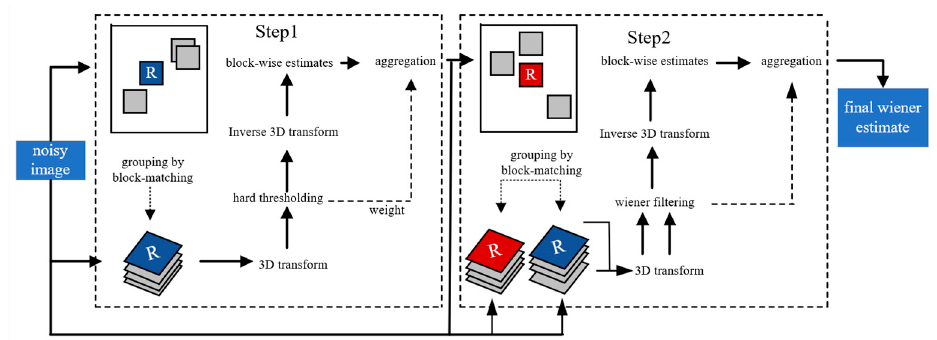
Figure 4. BM3D algorithm flow chart.